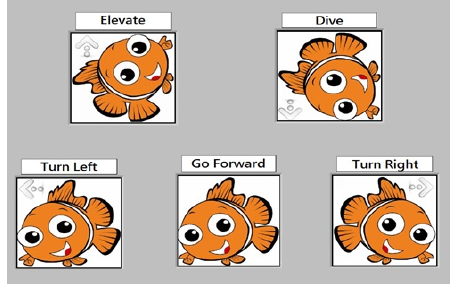
Table 1. Frequencies for a screen with a refresh rate of 60 Hz. Figure 2. The BCI layout for an air swimmer drone vehicle. Figure 2. The BCI layout for an air swimmer drone